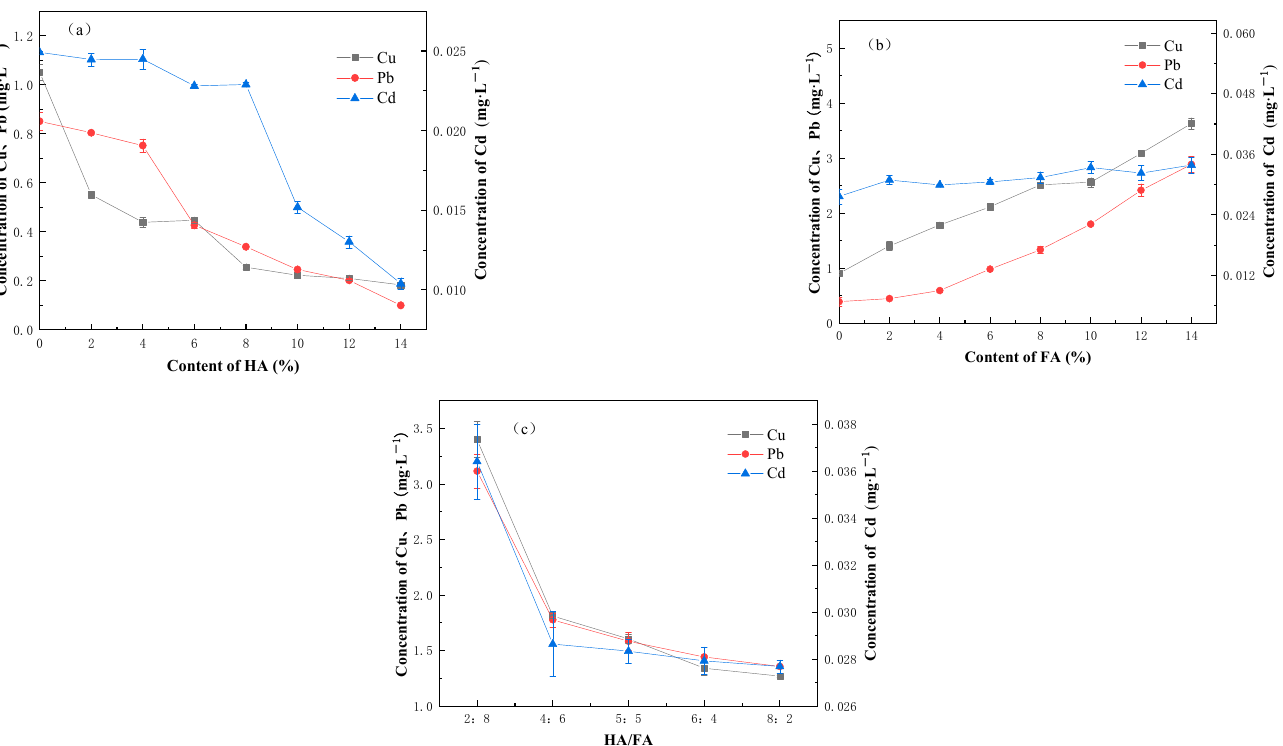
Figure 4. ( a ) Effect of humic acid on heavy metal leaching; ( b ) Effect of fulvic acid on heavy metal leaching; and ( c ) Effect of HA/FA ratio on heavy metal leaching.